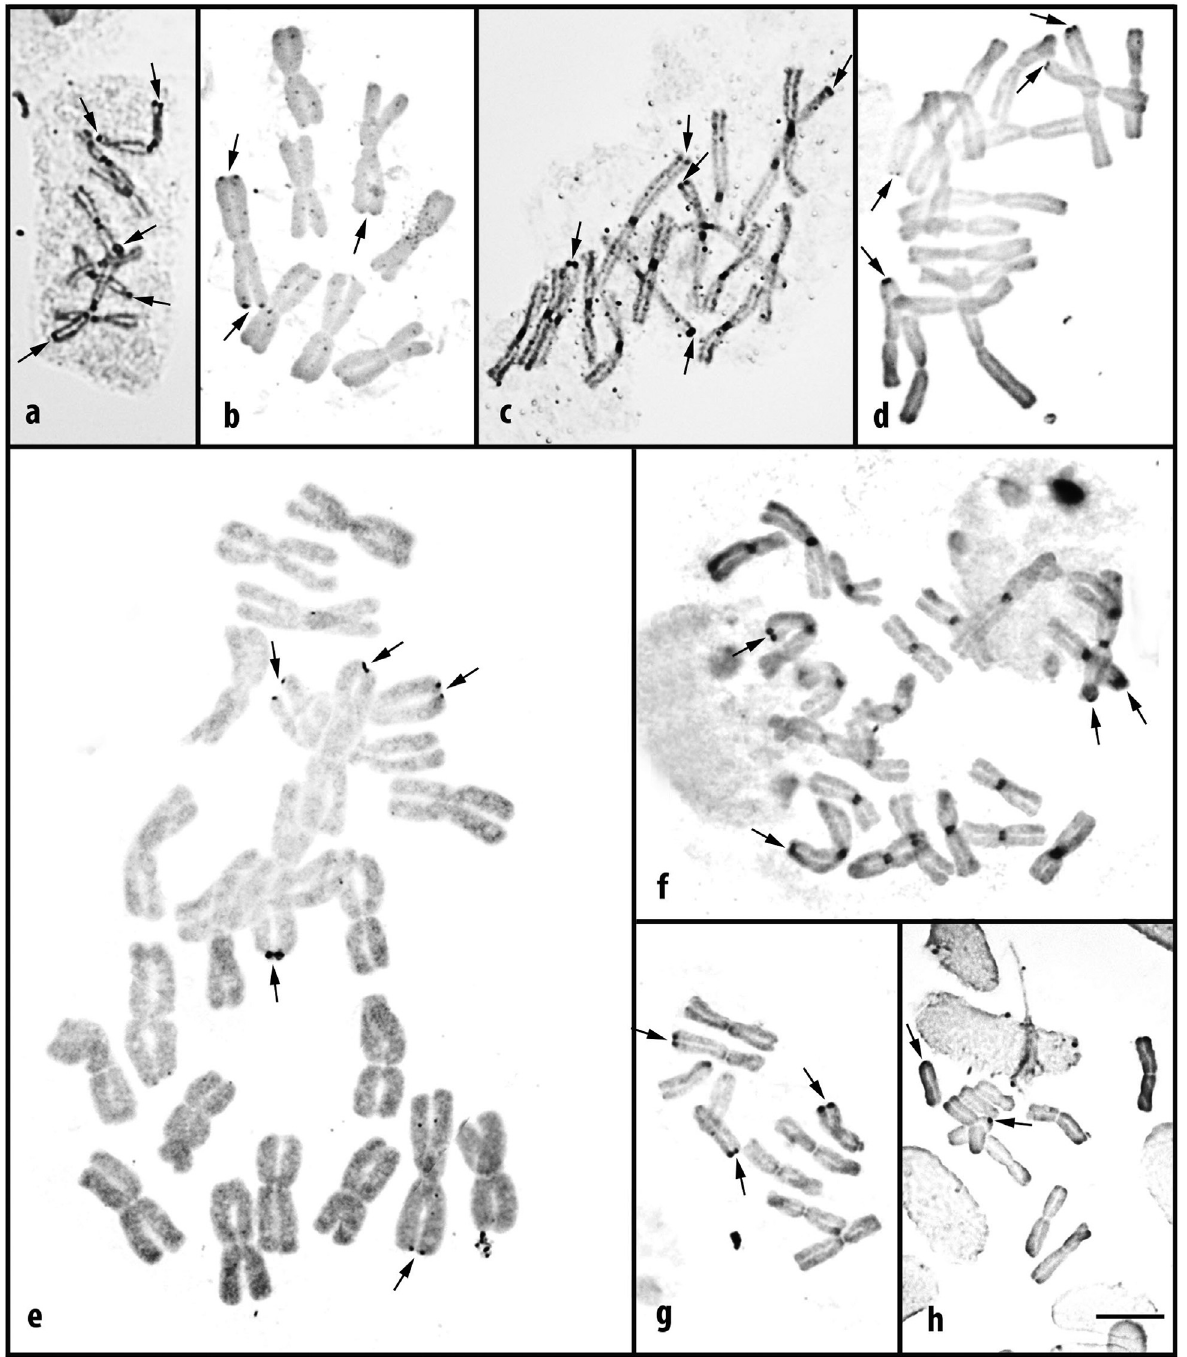
Figure 4 - NORs (arrows) in metaphases of Nothoscordum gaudichaudianum 2 n = 8 (a, b) and 2 n = 16 (c, d); N. izaguirreae (e, f); N. felipponei (g); N. marchesii (h).Silvernitrateimpregnationinroottips(a,c,f,g)ordirectlyonslides(b,d,e,h).Observeina,c,fproximalregionsstainedwiththesamein- tensity as NORs. Bar corresponds to 10 (cid:2)